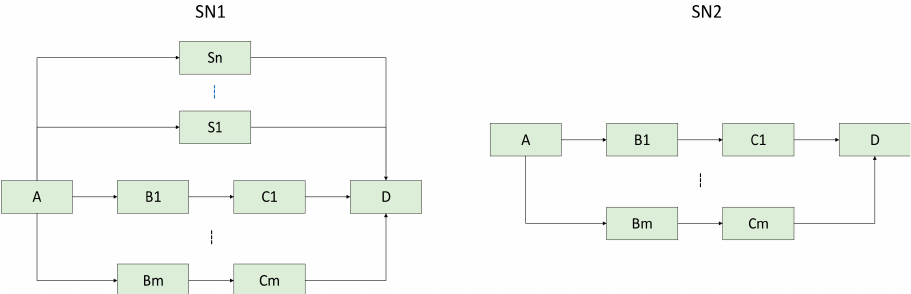
Figure 13. A subnet of geospatial service web.